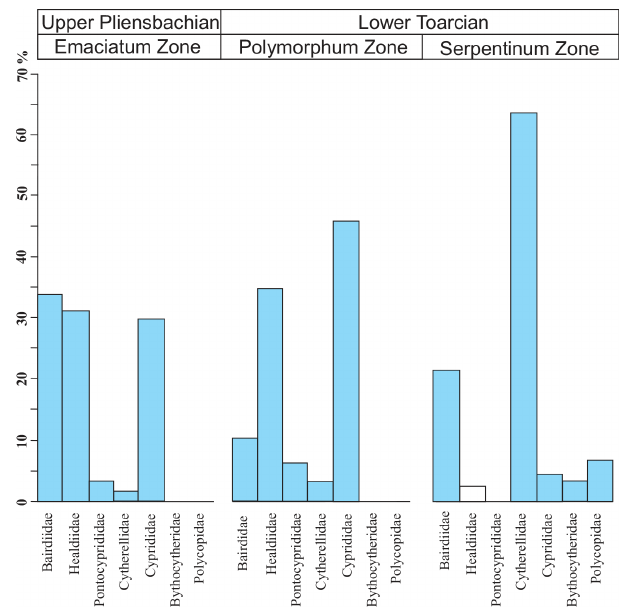
Figure 12. Average composition of ostracod assemblages accord- ing to families for the Emaciatum, Polymorphum, and Serpentinum zones. Note that the family Healdiidae in the Serpentinum Zone (white bar) corresponds to specimens prior to the global extinction of this family during the Jenkyns